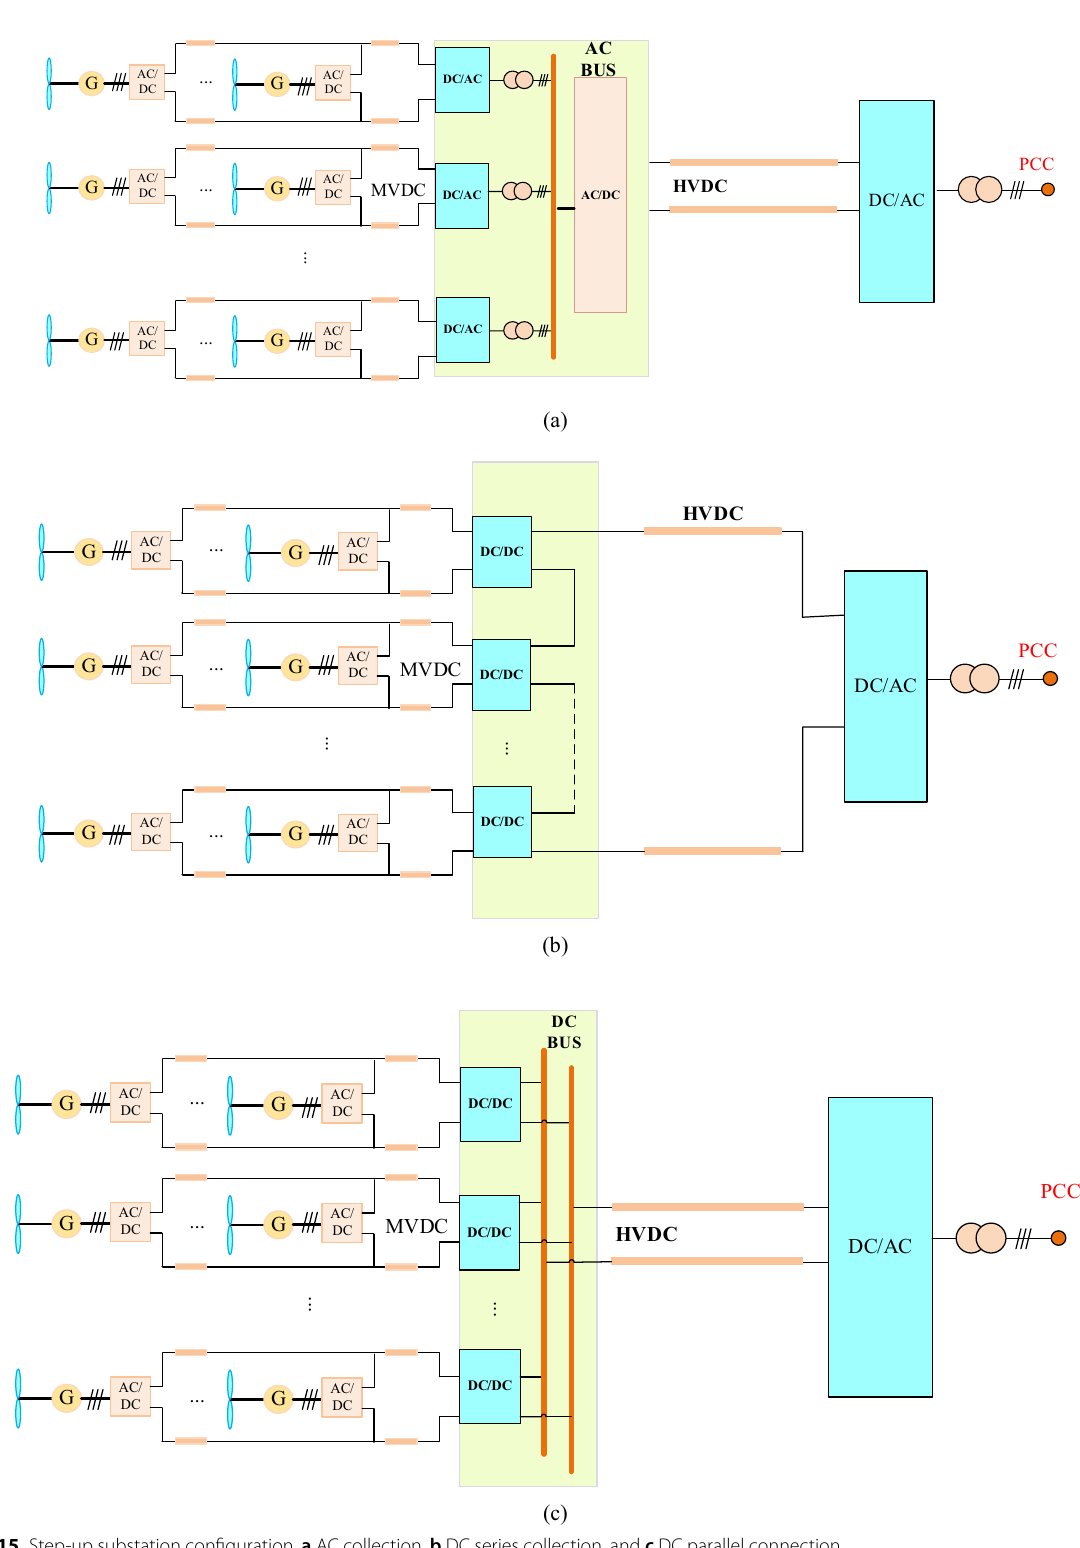
Fig. 15 Step-up substation configuration. a AC collection, b DC series collection, and c DC parallel